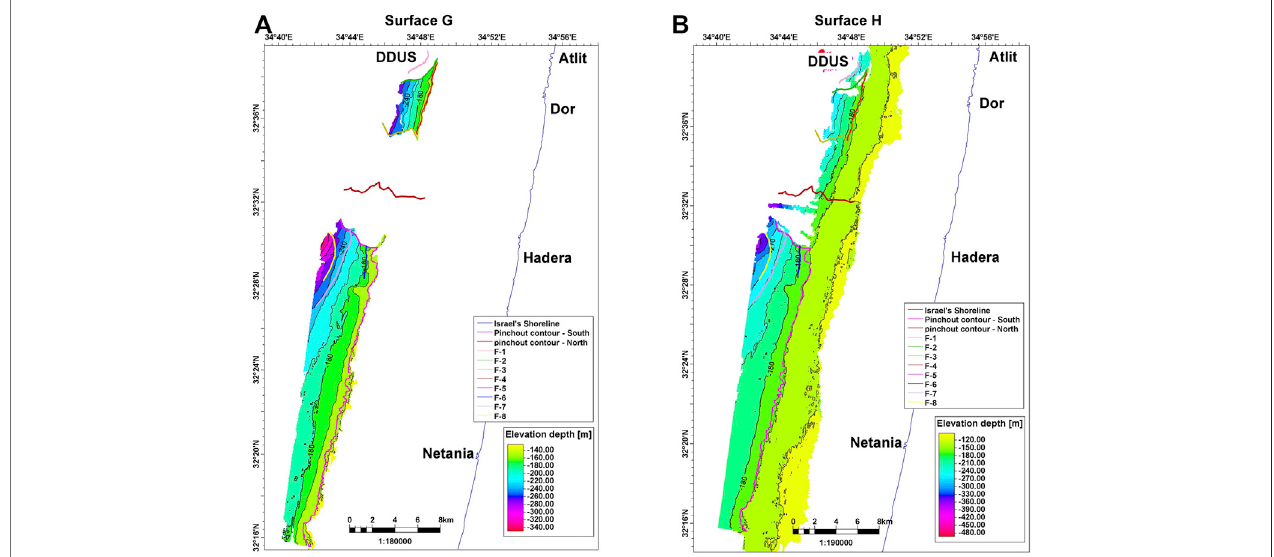
FIGURE 11 | Seismic mapping of horizons: (A) Horizon G; (B) Horizon H.